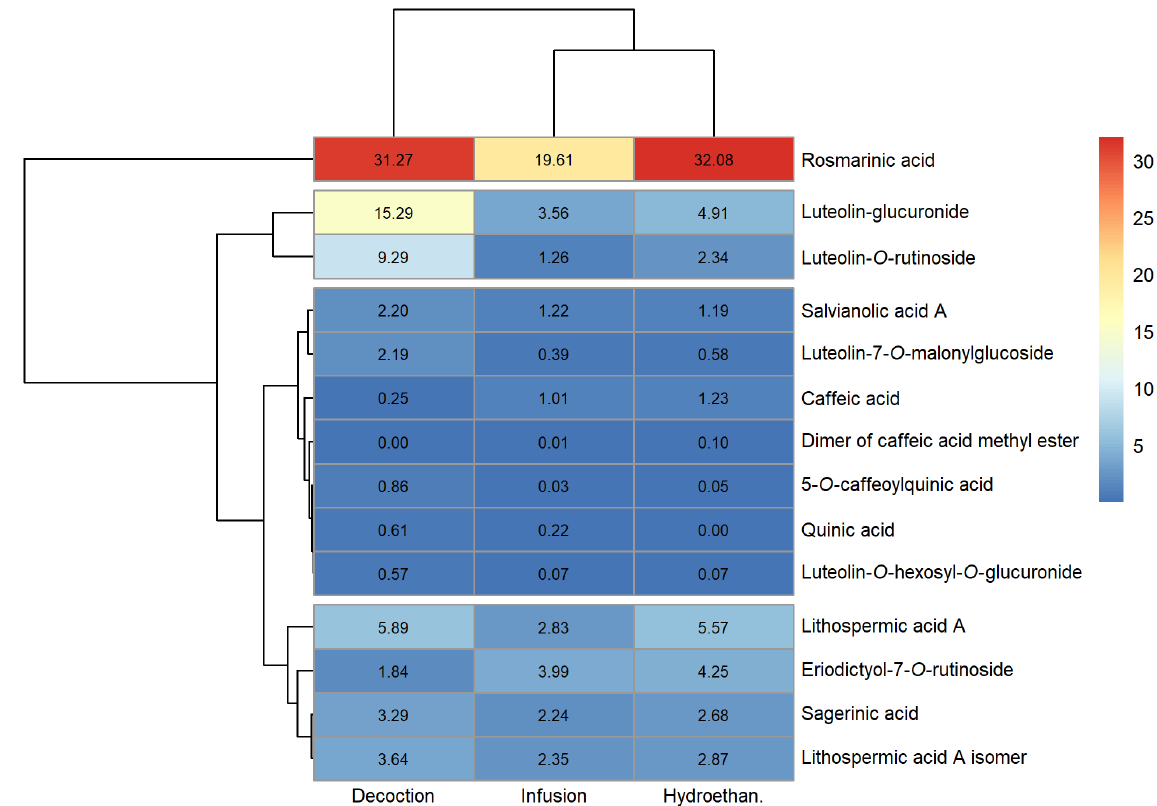
Figure 2. Clustered heatmap visualisation of phenolic compounds detected in lemon balm infusion, decoction and hydroethanolic extract (units: mg/g).